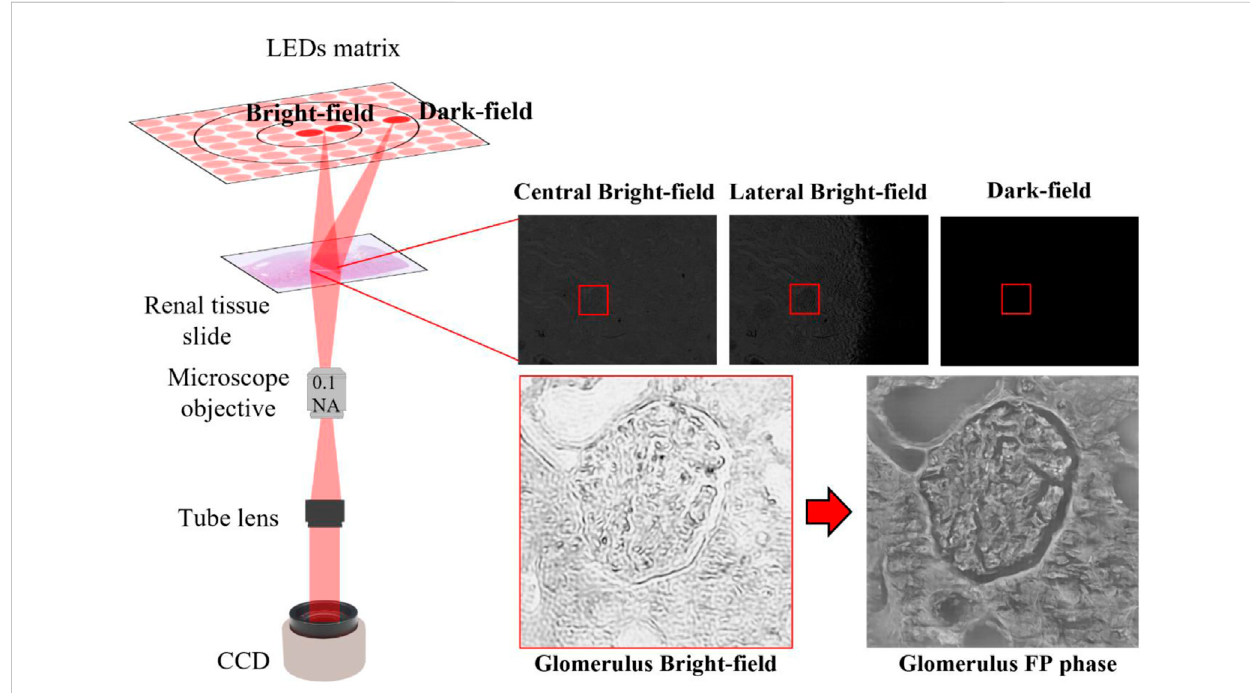
FIGURE 9 FPsetup: Leftside: sketch ofFPsetup; Right-side: raw images acquired according tothe LEDswitched on. Theglomerulus bright fi eld after iterative phase retrieval algorithm appears highly resolved in amplitude and phase